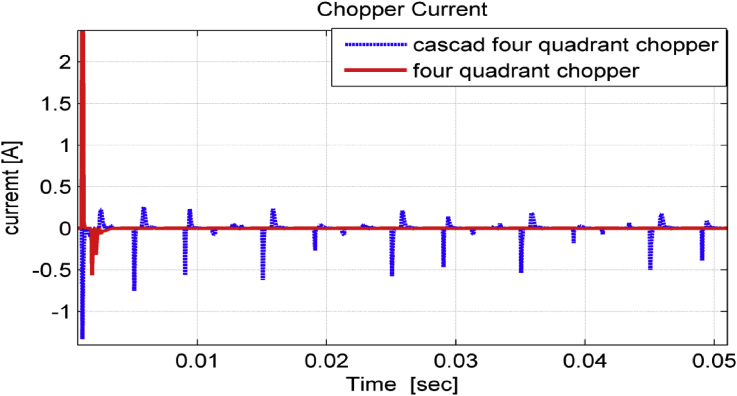
Chopper current.